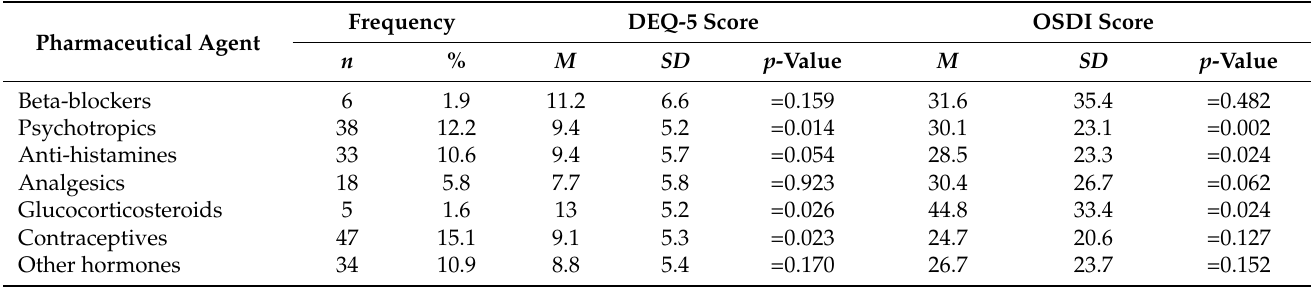
Table 2. Medication taken chronically by the study participants ( n = 312).